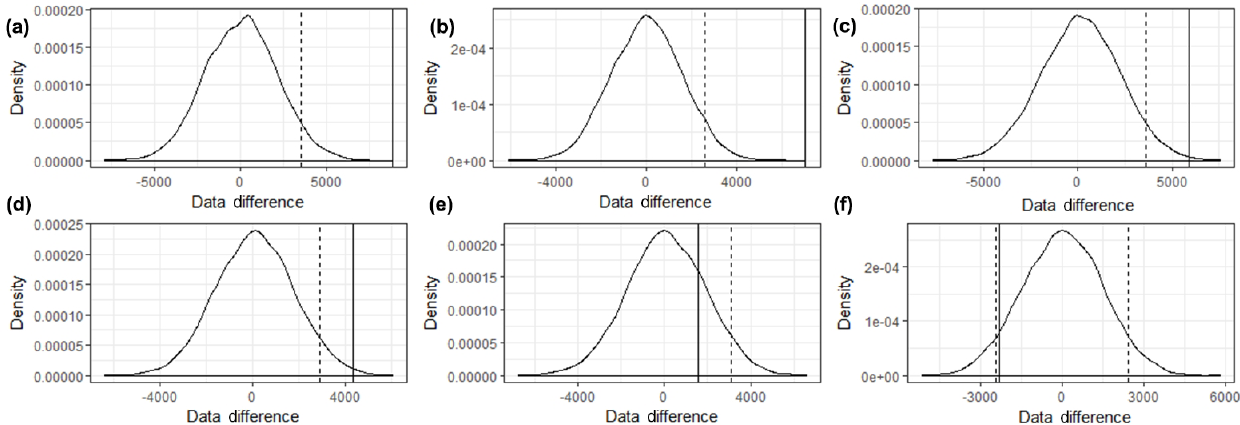
Figure 3. Density distributions of the mean difference obtained in the permutation test. (The dashed line is the mean difference corresponding to the 5% confidence level, while the solid line is the observed mean difference between two groups. The lower 5% confidence level is also shown for (f) because the data difference is negative. Here, (a) is the permutation test result for Group 1 and 3, (b) Group 2 and 3, (c) Group 1 and 4, (d) Group 2 and 4, (e) Group 1 and 2, and (f) Group 3 and 4.) Table 2. Permutation test results of ascending data at a geographical latitude of − 5 to 0 ◦ . Latitudinal Group region